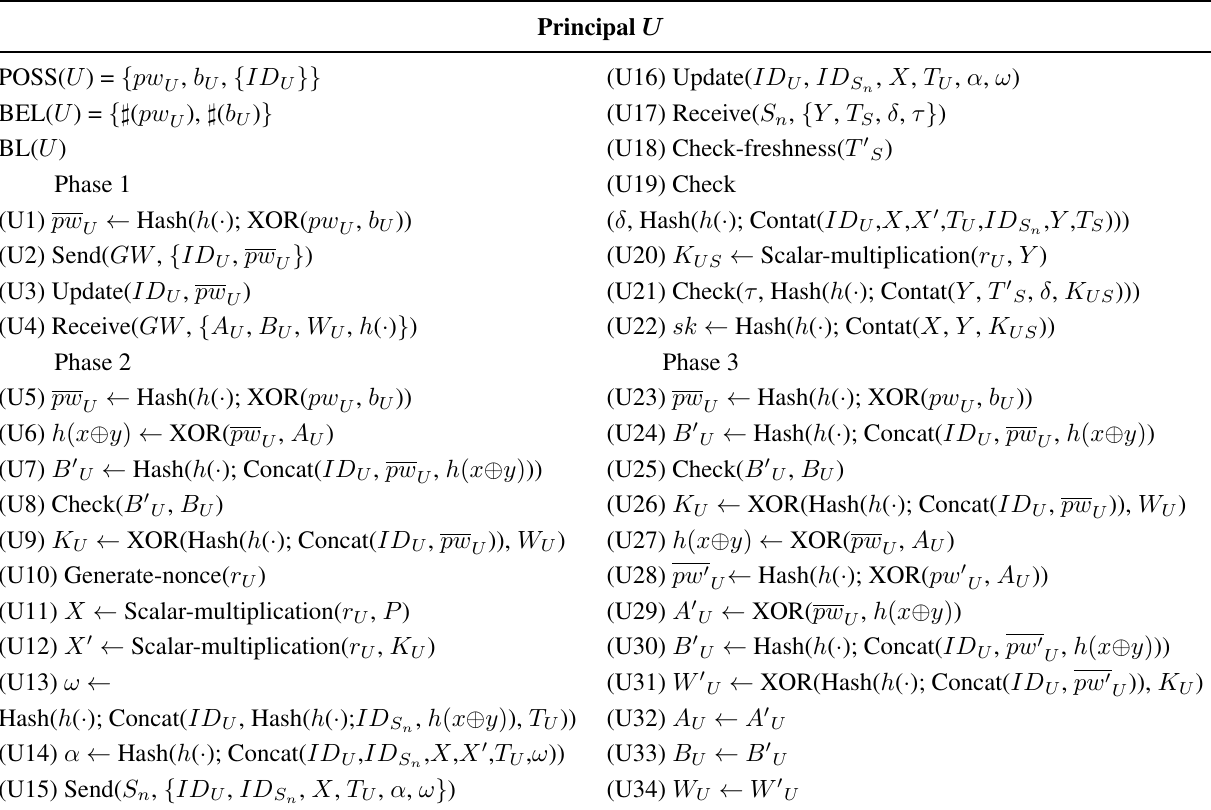
Table 6. Local sets specification for principal U